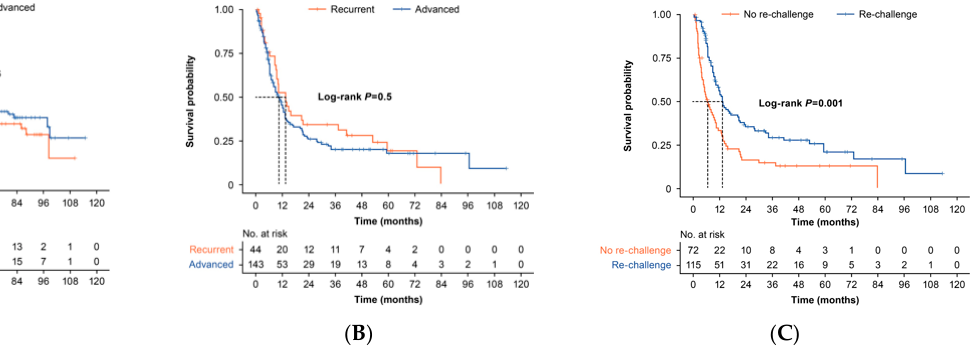
Figure 1. Distribution of first-line to second-line therapy across all patients. Sankey diagram showing the distribution of first-line to second-line therapy across all patients. The diagram indicates that most patients did not initiate second-line therapy.